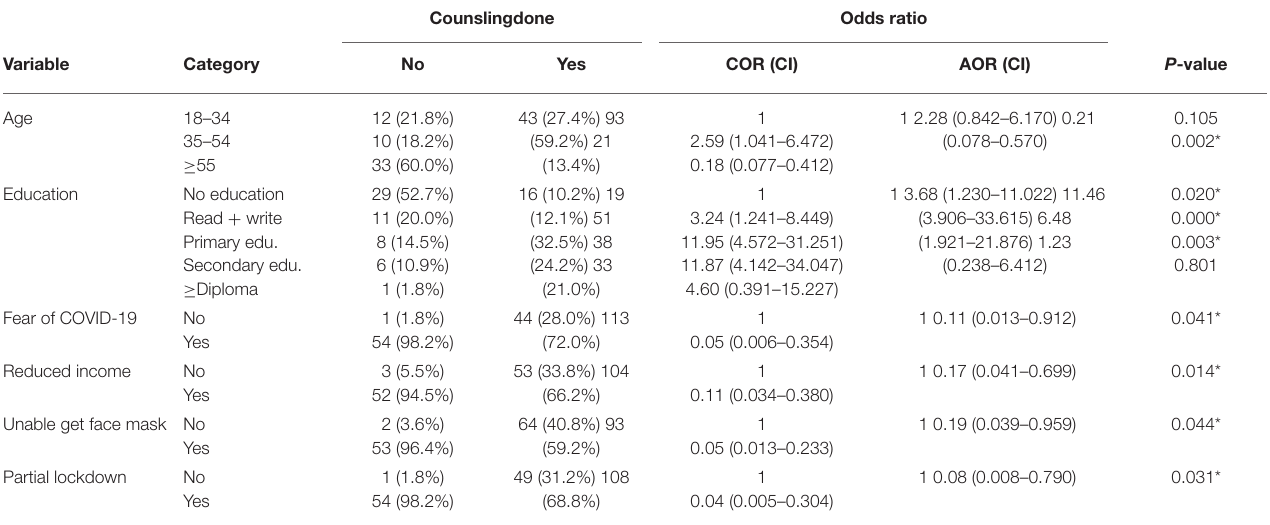
TABLE 10 | Bivariate and multivariate logistic regression analysis of the counseling variable, Addis Ababa, Ethiopia, 2021.